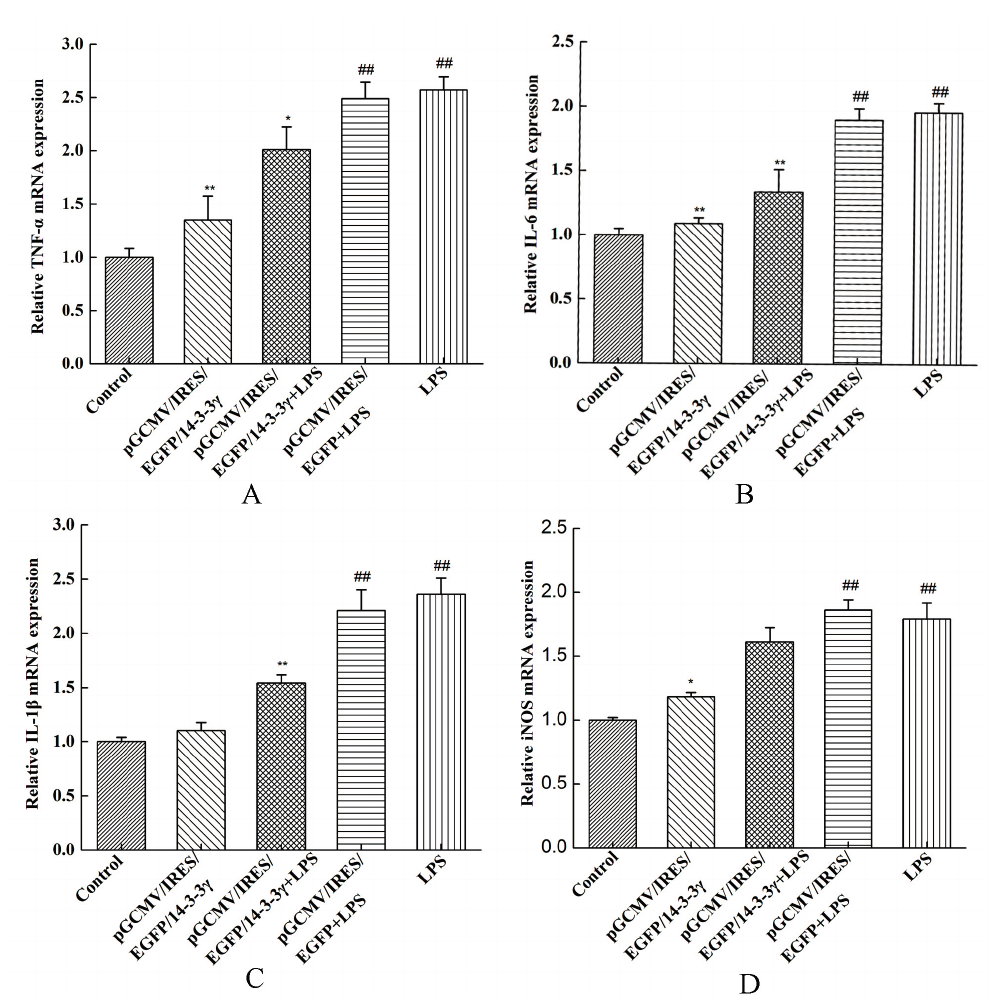
Figure 4. Effects of 14-3-3 γ overexpression on cytokine mRNA expression in LPS-induced